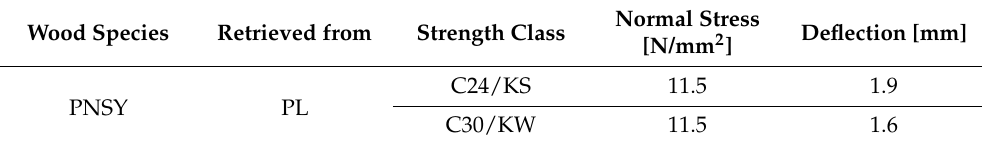
Table 15. Normal stresses and deflection (displacement) of E version short frames made of glued material with a finger-jointed lamella length of 200 mm (pine, country of origin: Poland). Wood Species